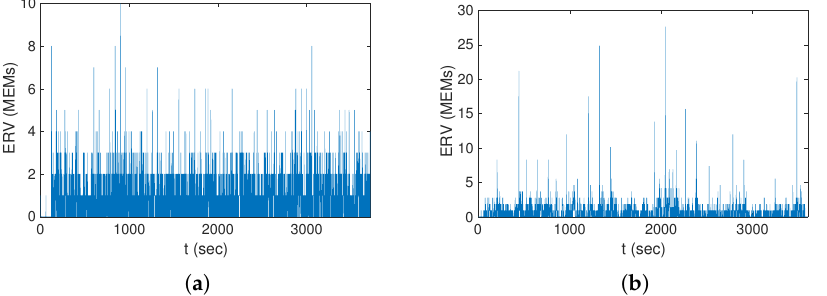
Figure 8. Temporal evolution of the exposure risk measured in MEMs for the ERV evaluation. ( a ) Plaza scenario; ( b ) Station